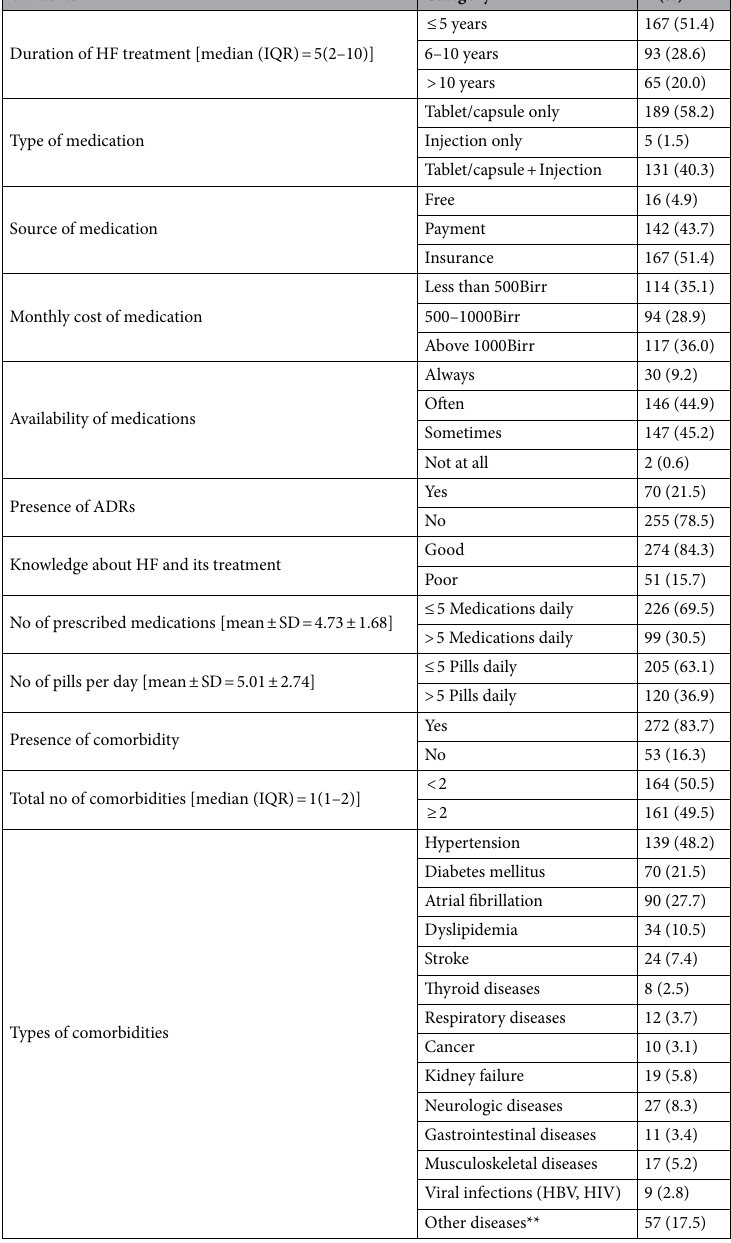
Table 3. Treatment-related characteristics of patients with heart failure attending cardiac clinic of Tikur Anbessa Specialized Hospital, Addis Ababa, Ethiopia, August 01–September 30, 2021 (n = 325). ADRs adverse drug reactions, No number, HF heart failure, IQR interquartile range, SD standard deviation, HIV human immunodeficiency virus, HBV hepatitis B virus, Other Diseases**: Left ventricle thrombus, Schizophrenia, Erectile dysfunction, Peripheral arterial disease (PAD), Benign prostate hyperplasia, aortic